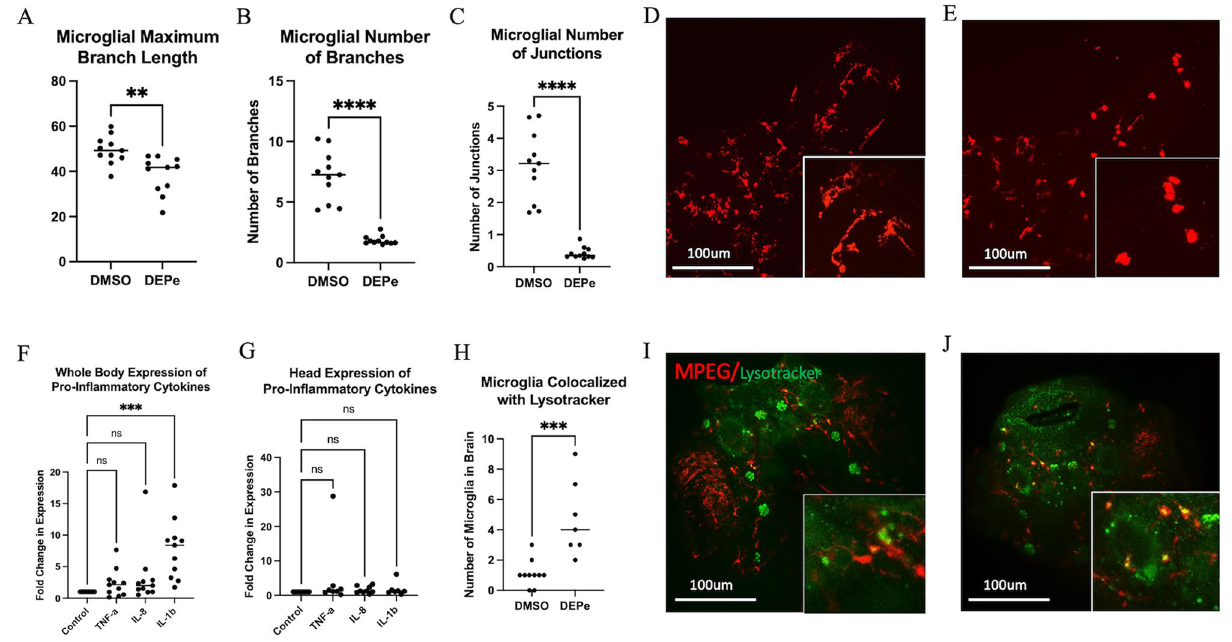
Figure 2. Microglial activation with DEPe exposure. Maximum branch length was significantly shorter ( A ), fewer numbers of branches ( B ) and fewer junctions ( C ) with DEPe exposure. Student’s T-test, **p < 0.01, ****p < 0.0001, n = 11, 11 (DMSO, DEPe). Dorsal view of 5dpf mpeg1:mCherry ZF brains revealing that control microglia ( D ) had more processes and were less rounded than DEPe-treated cells ( E ). Whole-body expression of pro-inflammatory cytokines with DEPe exposure, IL-1b expression was significantly upregulated compared to DMSO ( F ). There were no significant changes in expression of pro-inflammatory cytokines with DEPe exposure in the heads of ZF ( G ). For F and G, one-way ANOVA with Dunnett’s test, ***p < 0.001, n = 5 samples. Significantly more microglial cells colocalized with lysotracker-labeling 5dpf in DEPe-treated microglia ( H , J ) compared to DMSO-treated controls ( H , I ). Student’s T-test, ***p < 0.001, n = 10, 7.